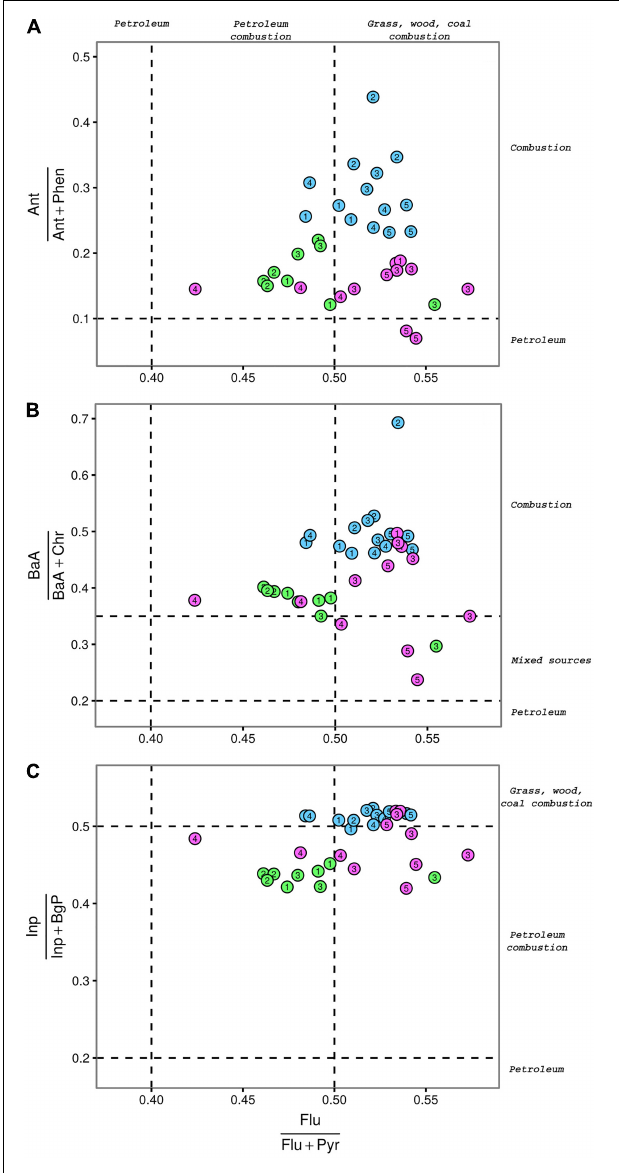
FIGURE 2 | Scatter plots between molar ratios of selected PAHs calculated for surface sediments collected at the port of Cagliari (blue), El Kantaoui (green), Heraklion (pink). Flu/Flu + Pyr vs. Ant/Ant + Phe (A) , Flu/Flu + Pyr vs. Inp/Inp + BgP (B) , Flu/Flu + Pyr vs. BaA/BaA + Chr (C) . Dashed lines identify the transition points between different pollution sources according to Yunker et al. (2002). The digit in the symbol identifies the sampling station within each port